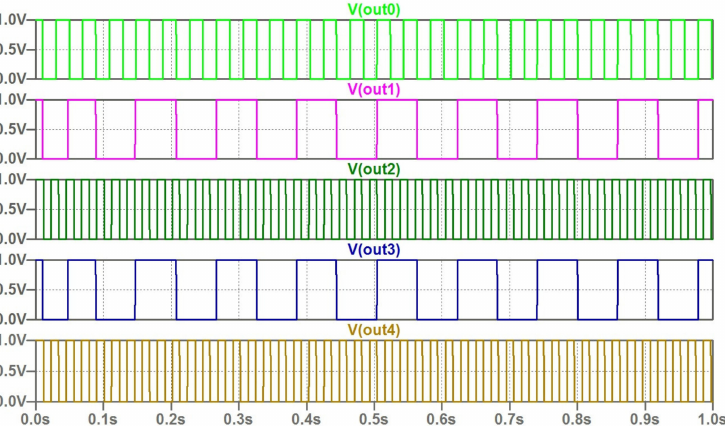
Figure 8. The output waveforms of the coupled oscillators according to encoded frequencies. The following set of oscillator frequencies corresponds to considered example: f 0 = 25.2975, f 1 = 11.2486, f 2 = 44.6236, f 3 = 11.2486, f 4 = 44.6236